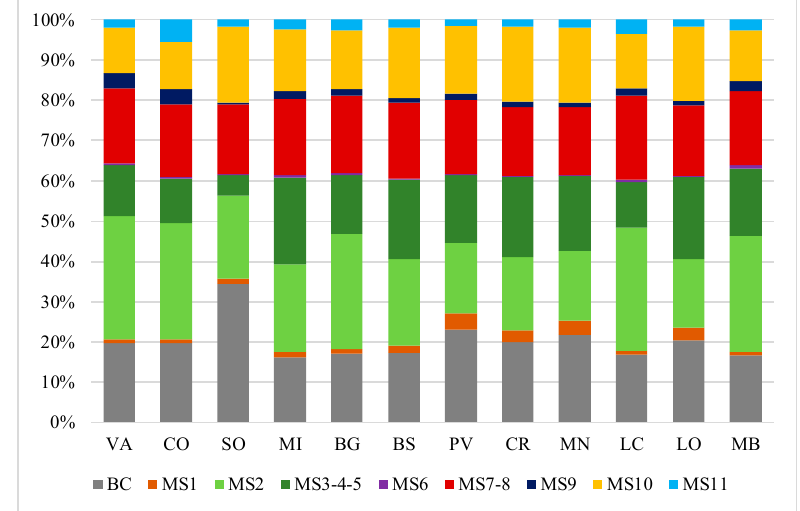
Figure 4. PM10 Source apportionment results for each Province in Lombardia region.